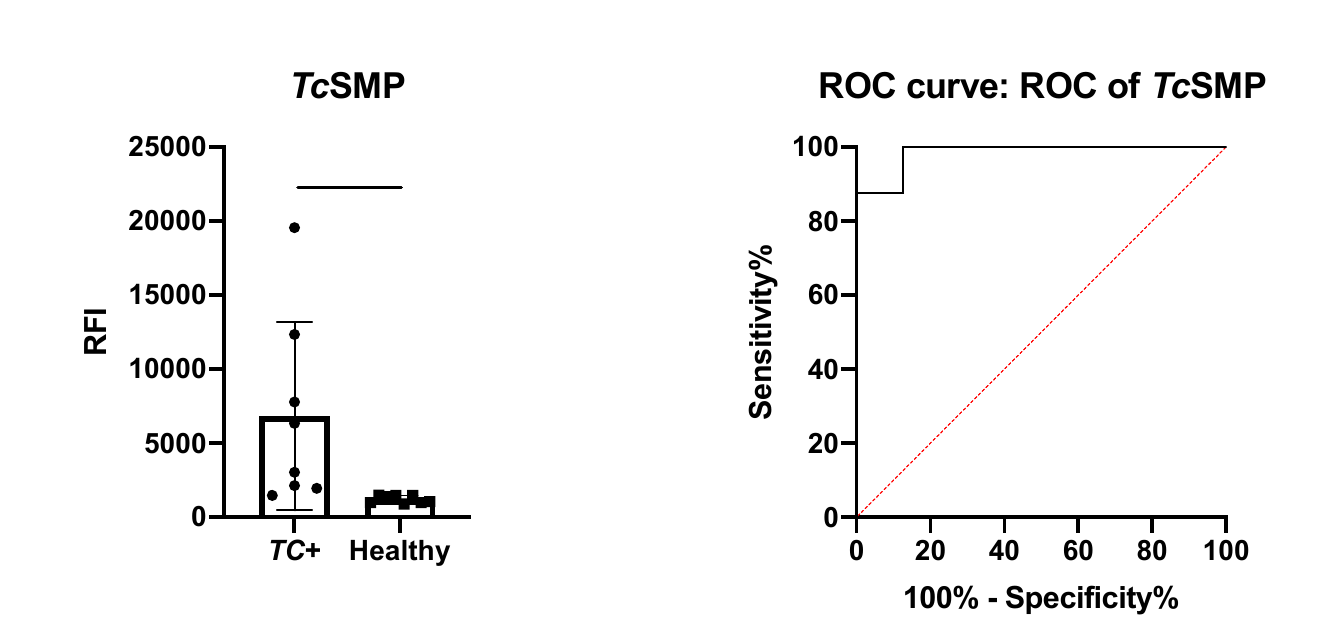
Figure 4. Immune sera reactivity potential of recombinant Tc SMP. Left panel: unpaired t -test results for the detection of Tc SMP-specific human IgG. Protein arrays were probed with sera (N = 8) from patients with confirmed T. cruzi infections (TC+) and healthy control patients (N = 14). Significative: p < 0.05.